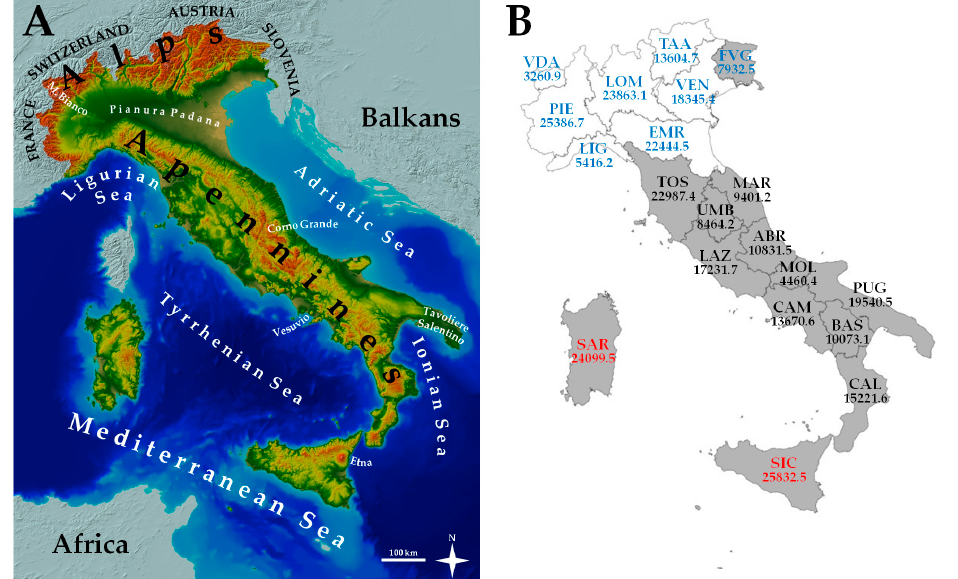
Figure 1. ( A ) Location and geographical features of Italy (from Tarquini et al. [56], modified). ( B ) Division into administrative regions of the Italian territory (VDA: Valle d’Aosta; PIE: Piemonte; LOM: Lombardia; TAA: Trentino-Alto Adige; VEN: Veneto; FVG: Friuli-Venezia Giulia; LIG: Liguria; EMR: Emilia-Romagna; TOS: Toscana; UMB: Umbria; MAR: Marche; LAZ: Lazio; ABR: Abruzzo; MOL: Molise; CAM: Campania; BAS: Basilicata; PUG: Puglia; CAL: Calabria; SIC: Sicilia; and SAR: Sardegna) with the indication of continental (regions in blue), peninsular (regions in black), and insular Italy (regions in red). The number under the abbreviated name of each region indicates its area in km 2 . Regions for which we provide new floristic data on the basis of our study are highlighted in gray.